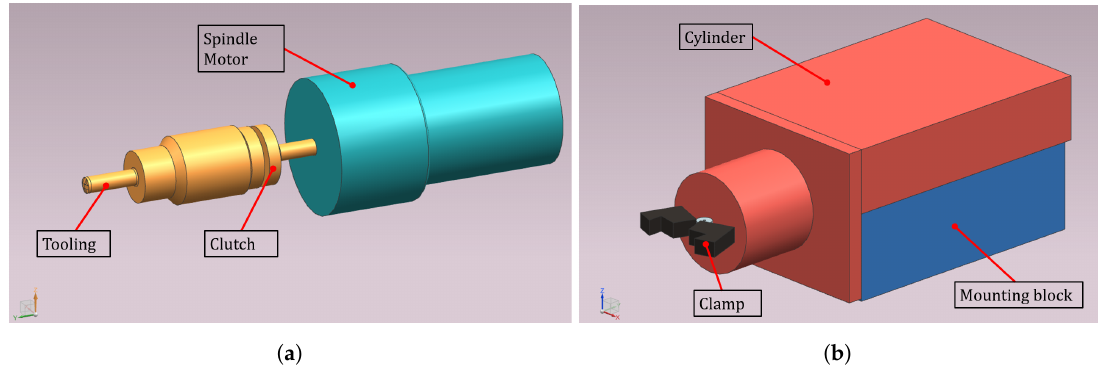
Figure 7. ( a ) torquing motor and tool; ( b ) clamp assembly.